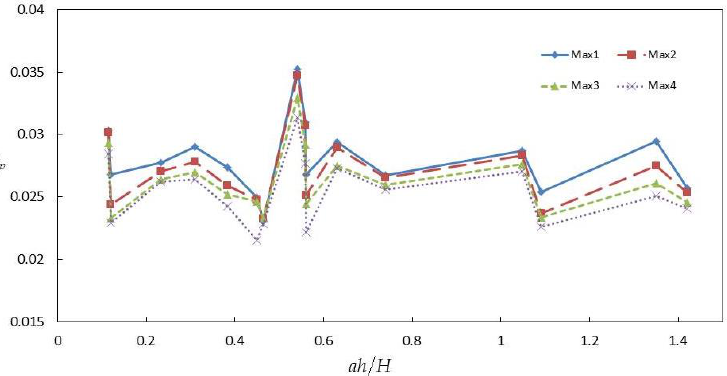
Figure 11. Generalized roughness coefficient n p varies with the comprehensive parameter ah/H . (calculated from original velocity data with different velocity integration in experiments of Dunn et al. [1]).